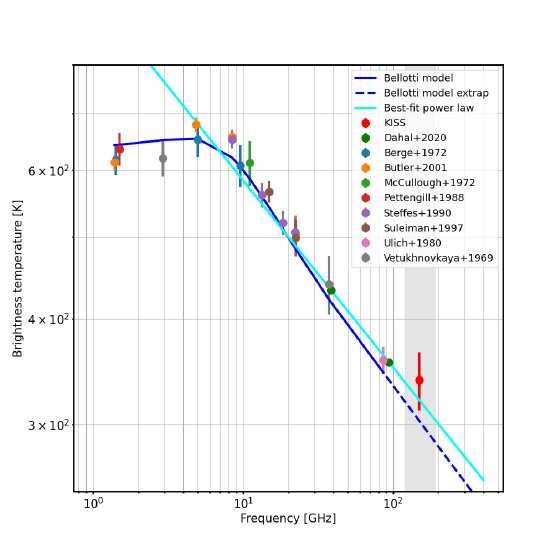
Figure 2. Venus brightness temperature as a function of frequency. We present a collection of radio and mm wavelength measurements including those of KISS. The blue and cyan lines represent two models for the Venus brightness temperature. [12]